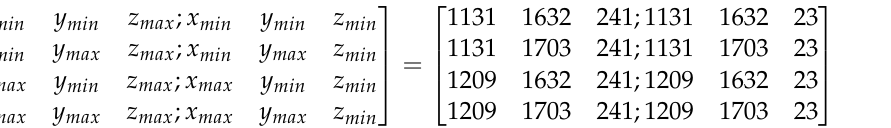
) and its expansion to the next level ( S 3 1